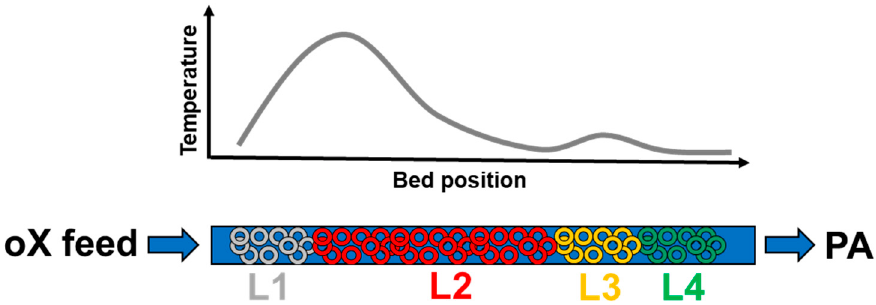
Figure 2. Typical four layer-system and axial temperature profile with Clariant’s commercial phthalic anhydride (PA) catalyst.